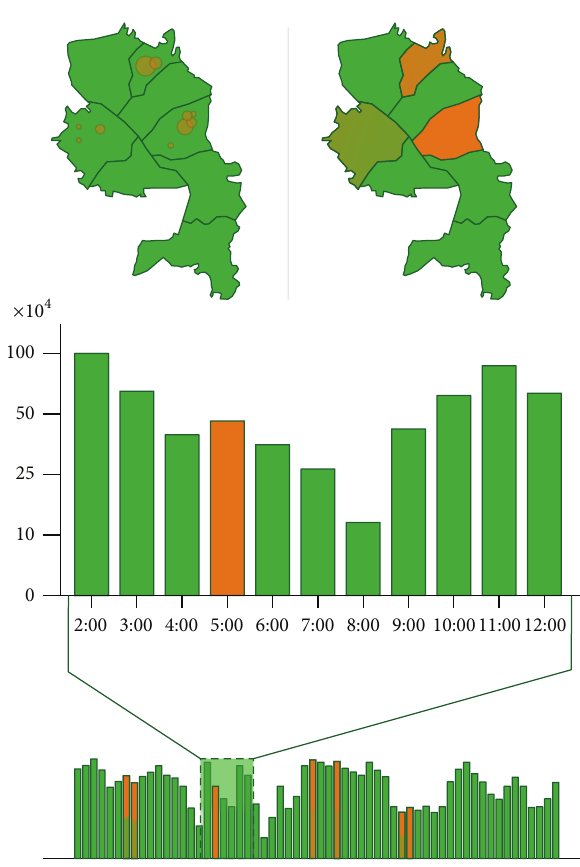
Figure 5: Acquiring more detailed information through the re- search